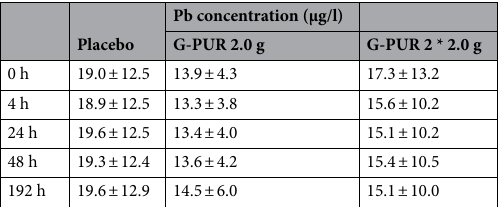
Pb concentration (µg/l) Placebo G-PUR 2.0